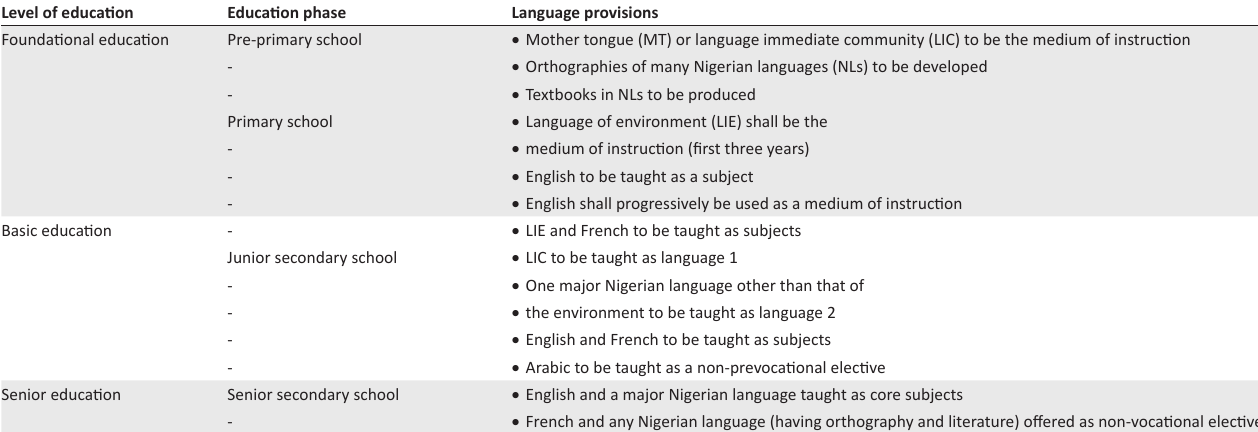
TABLE 1: Language provisions in the national policy on